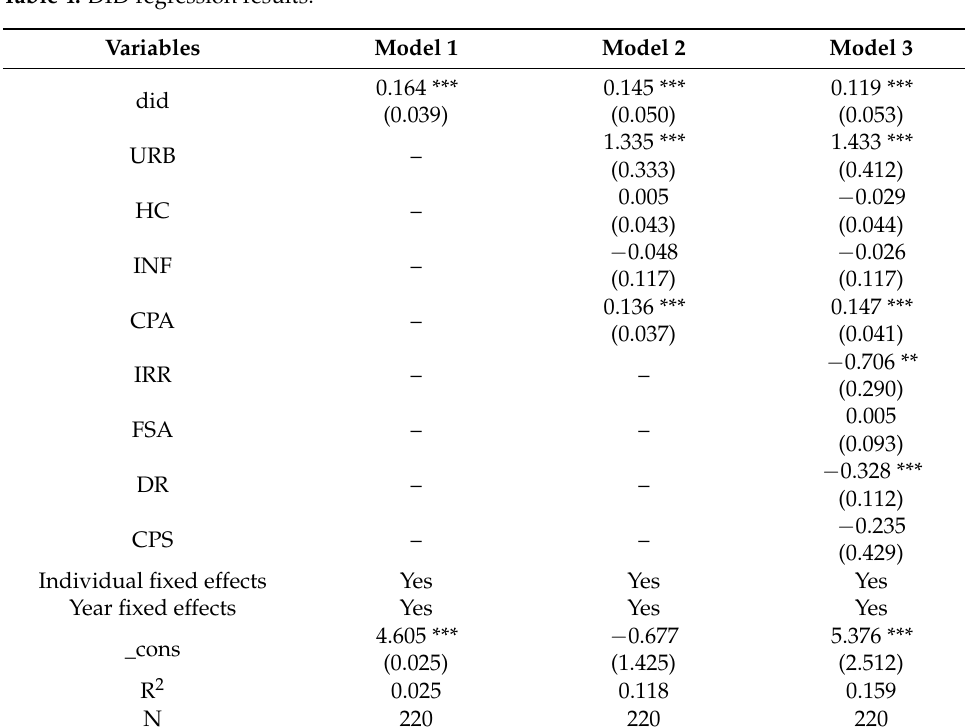
Table 4. DID regression results.